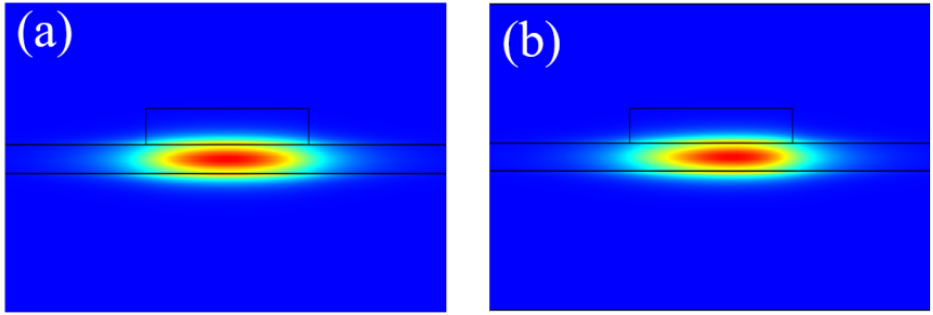
Figure 9. Cross-section mode field distribution of ( a ) a BIC straight waveguide and ( b ) a BIC bent waveguide.